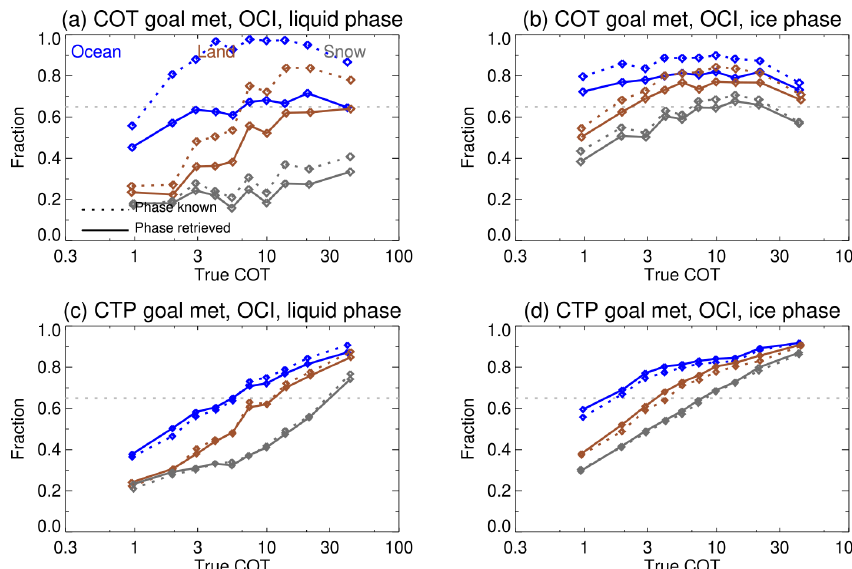
Figure 12. Fraction of points where the retrieval error meets the PACE mission goal uncertainties (25% for liquid-phase COT, 35% for ice-phase COT, and 60mb for CTP for COT ≥ 3) as a function of COT for OCI. The dotted pale grey line shows the 65% threshold for achieving these goal uncertainties. Solid and dashed lines show results for best-fit phase vs. known true phase respectively. Blue, brown, and grey indicate ocean-like, land-like, and snow-like simulations. Panels (a) and (c) show results for liquid-phase simulations and panels (b) and (d) for ice-phase simulations. Table 4. Statistics of CTP retrieval error in simulated single-layer cloud scenes for OCI and OLCI for the subset of cases where COT ≥ 3.